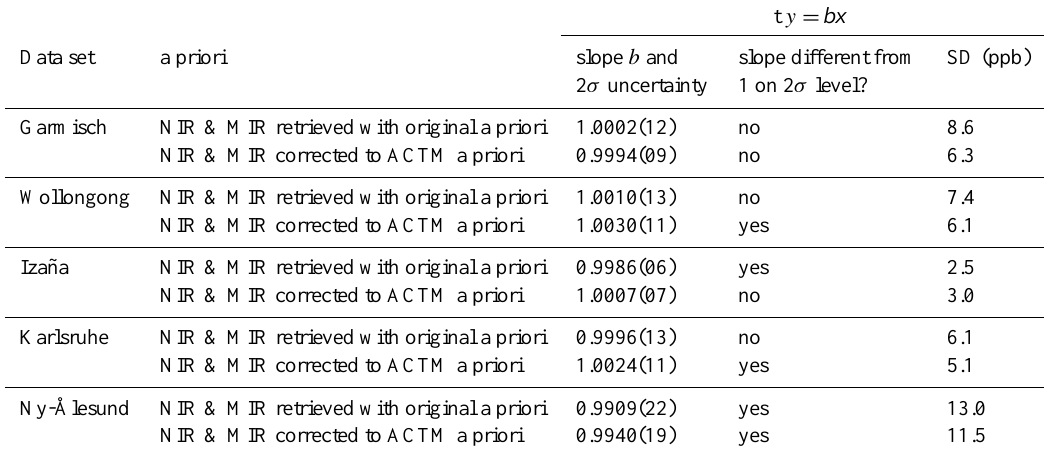
Table 2. Slope of linear scatter plot fits between multiannual data sets of NIR and MIR XCH 4 retrievals using varied a priori profiles. Slope uncertainties are derived from the fit and are at 2 σ . The slope uncertainty is illustrated in brackets corresponding to the third and fourth decimal place of the slope value; i.e., (12) implies a slope uncertainty of ± 0.0012. Standard deviations of NIR–MIR differences are provided as SD. Data are monthly means constructed from same-day measurement